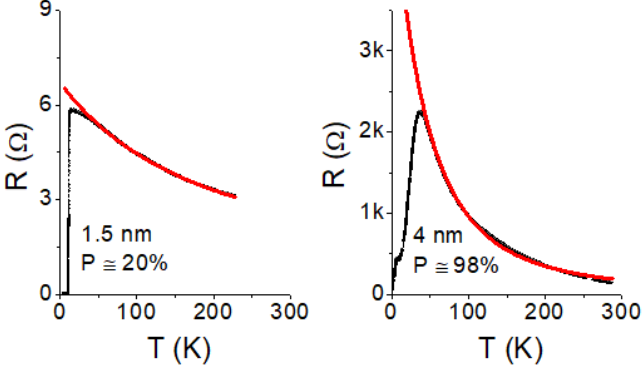
Figure 1. R ( T ) curves for samples with di ff erent barrier thicknesses. Black dots are experimental points, red line is the resistance obtained by fitting data with a standard semiconducting model below T Curie . Left: junction with low spin polarization. Right: junction with high spin polarization, the resistance drop below T Curie is clearly